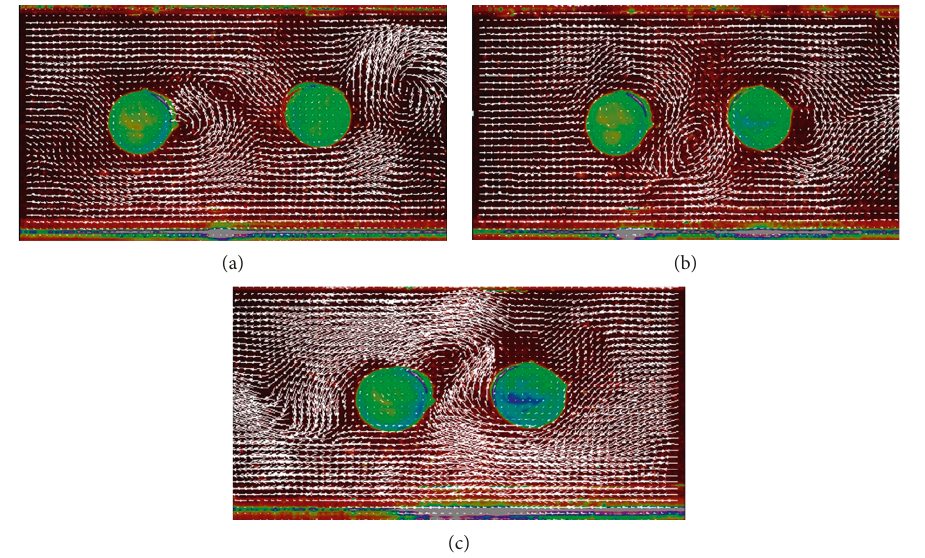
Figure 7: PIV measurement for the case with Re � 3515.1 and KC � 8.4, (a) gap ratio is 2, (b) gap ratio is 1.5, and (c) gap ratio is